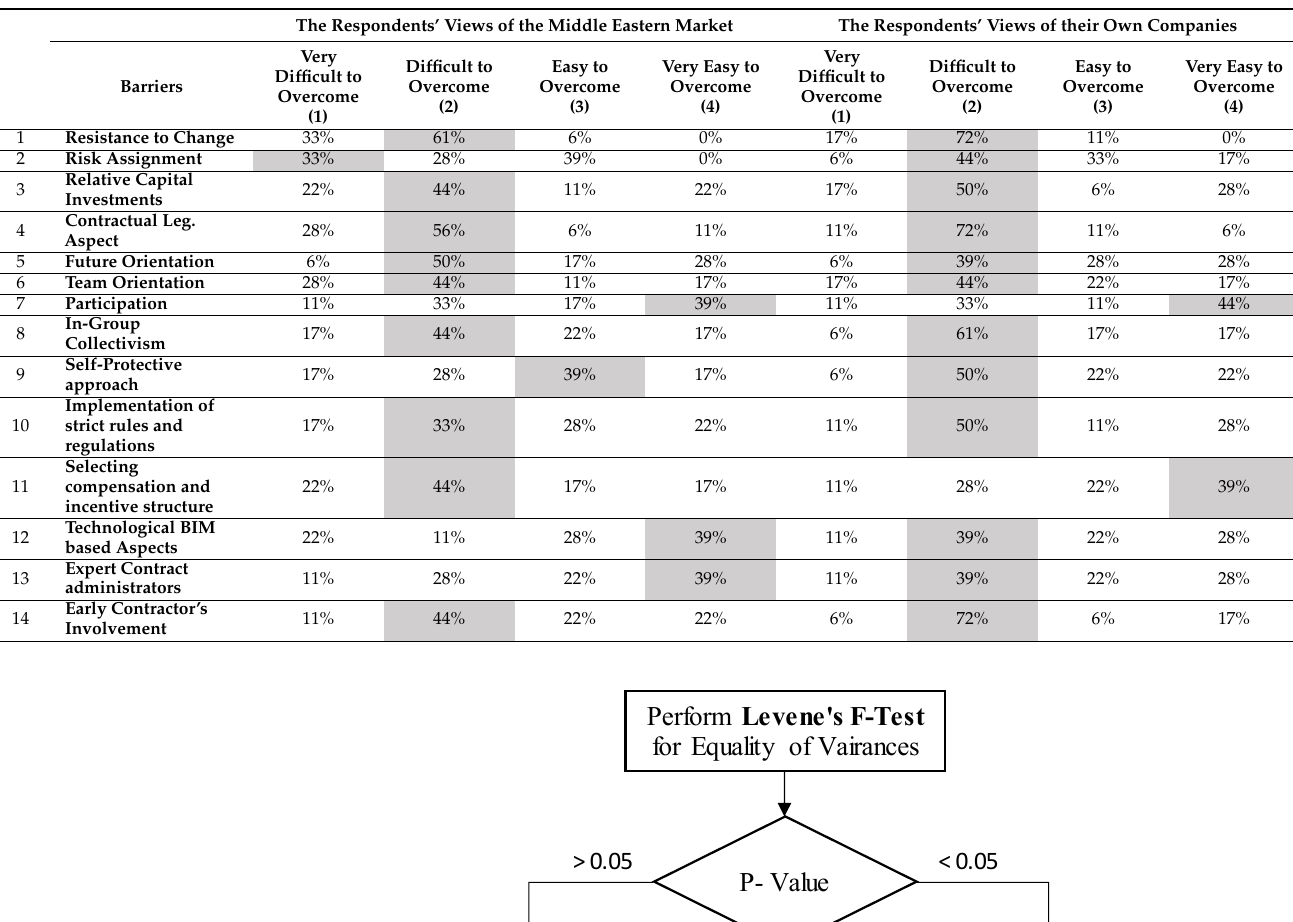
Table 4. Percentile scale ranking of the expert opinions.